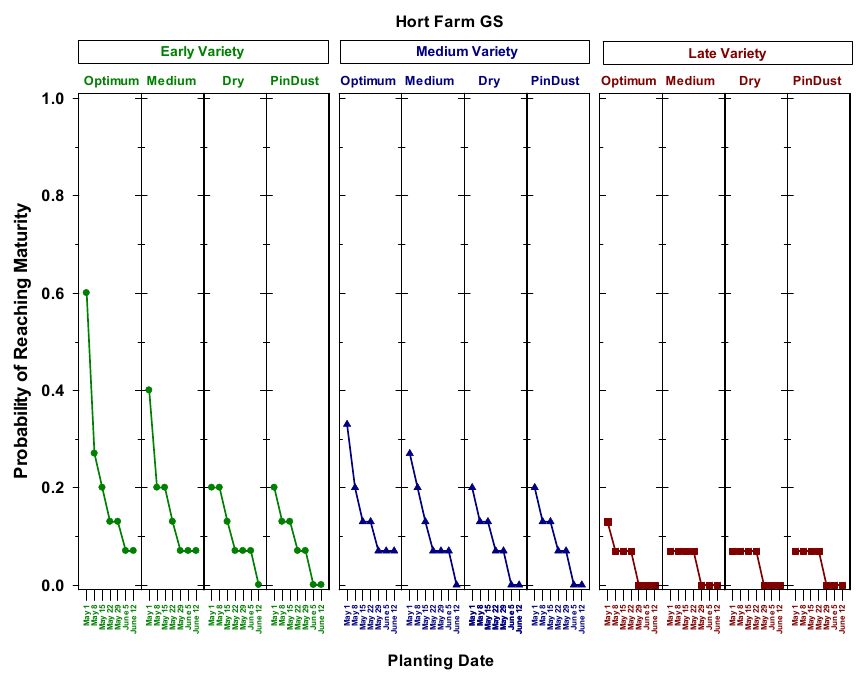
Figure 10. Probability of sorghum reaching physiological maturity at Hort Farm, Colorado, for seven planting dates using non ‐ stressed (GS) phenological parameters, three maturity classes, and four seedbed water conditions at planting.